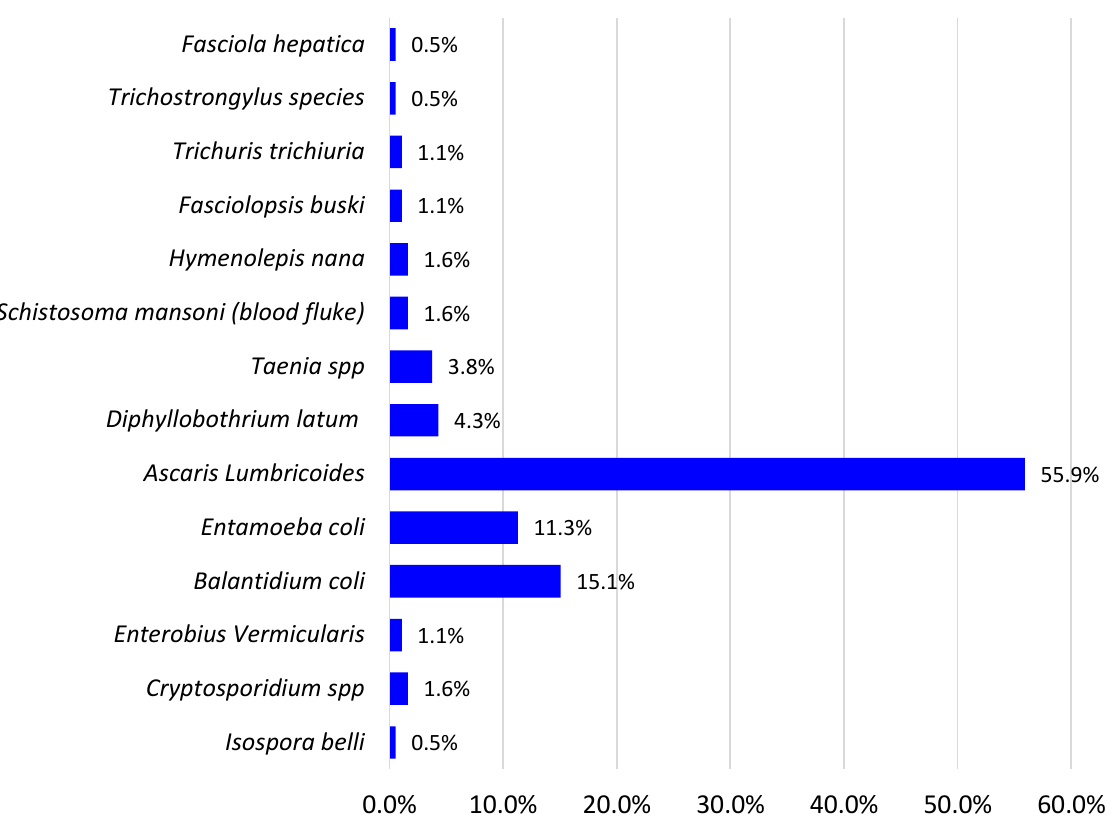
Figure 1. Intestinal parasites isolated.